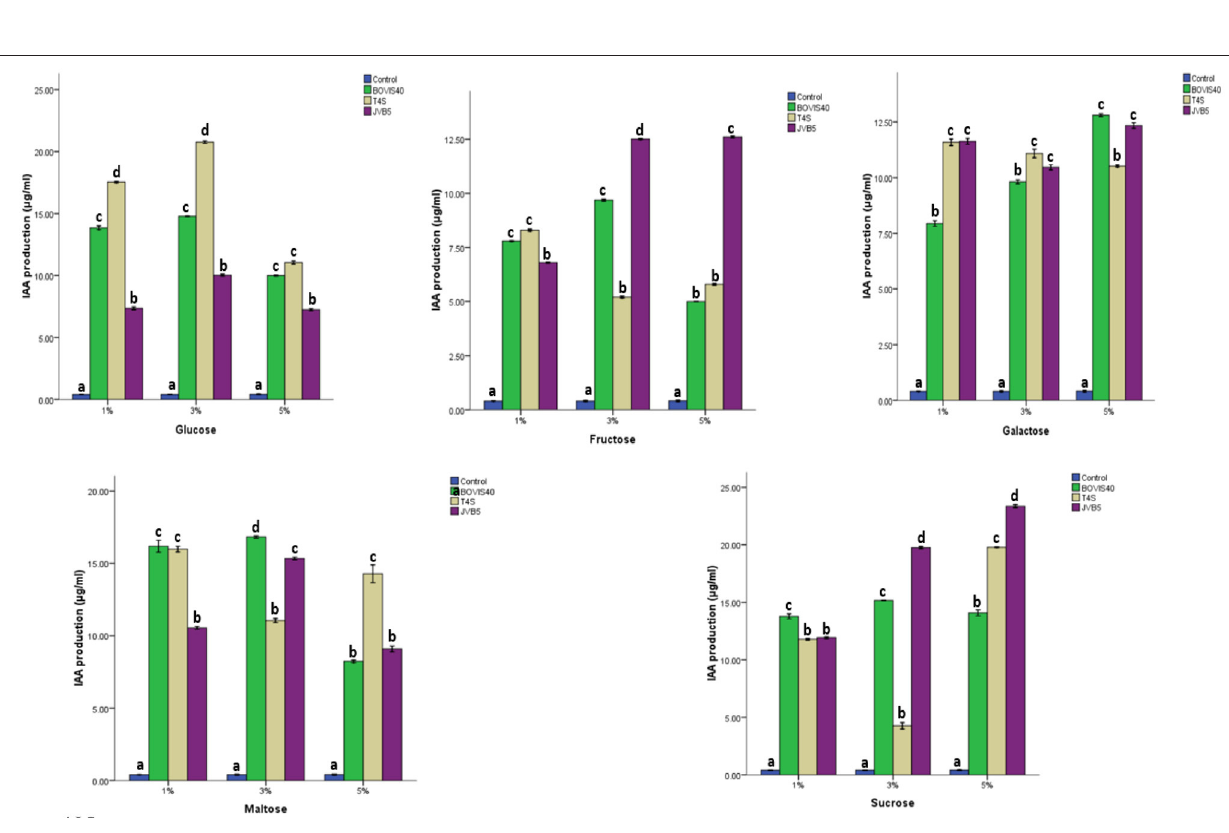
Frontiers in Sustainable Food Systems |